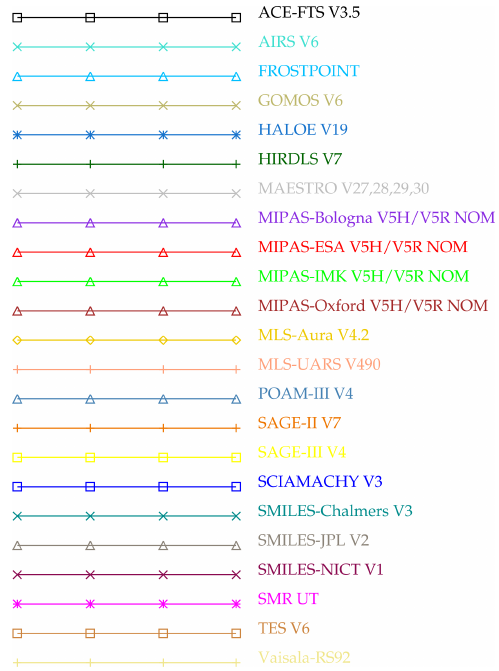
Figure 2. The colors and symbols used to identify instruments in multi-instrument